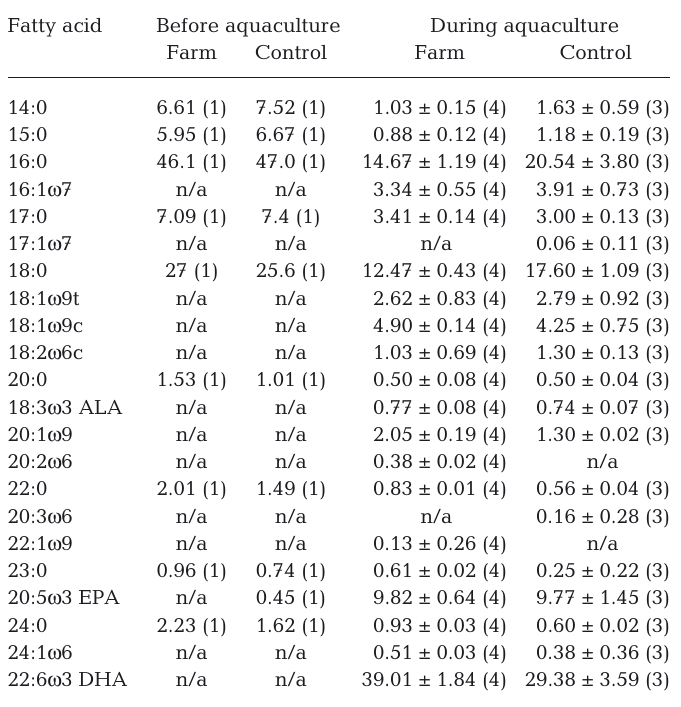
Table 4. Relative fatty acid composition of the harpacticoid copepod fam- ily Canuellidae from ‘farm’ and ‘control’ sites at Stn SS (see Table 1 leg- end for abbreviation) at a scallop farm in Laizhou Bay, China before and during seasonal aquaculture in 2016. Values for ‘during aquaculture’ are mean ± SD, with the number of replicates given in parentheses. ALA: alpha-linolenic acid; EPA: eicosapentaenoic acid; DHA: docosahexa- enoic acid; n/a: not